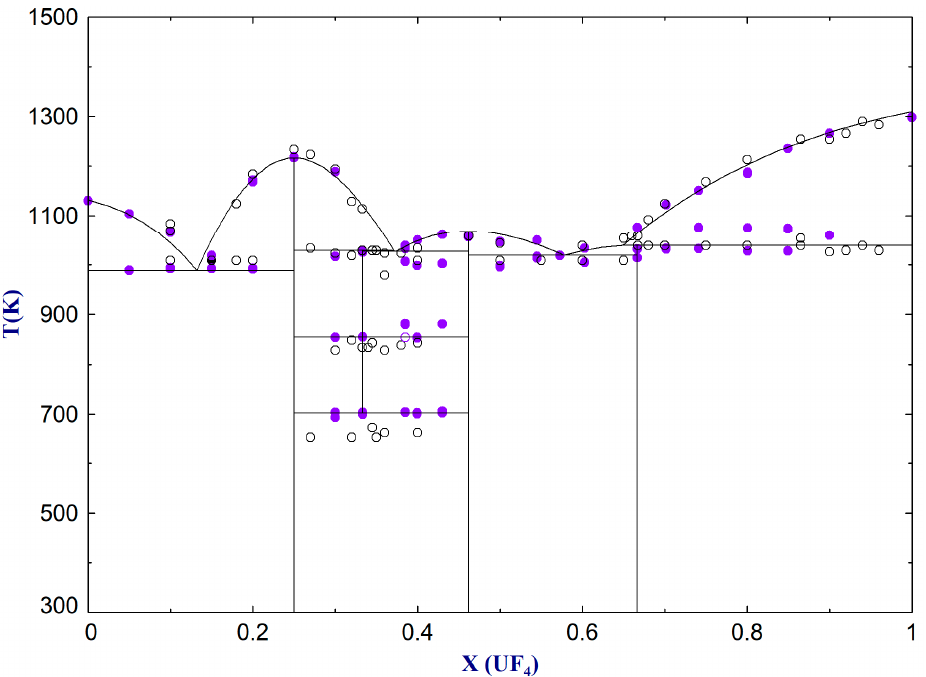
Figure 3. The calculated KF-UF 4 phase diagram superimposed with our experimental data (purple solid circles) and experimental data from Thoma et al. [16] (hollow circles).